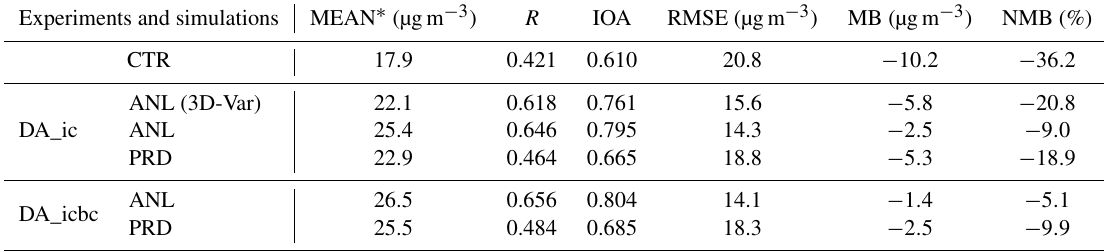
Table 4. Statistical metrics for the experiments of DA_ic and DA_icbc. Experiments were evaluated for the 6-hourly assimilated analysis run (ANL) and for the 1d prediction run (PRD). The ANL run using 3D-Var in the DA_ic experiment is included for comparison. Experiments and simulations